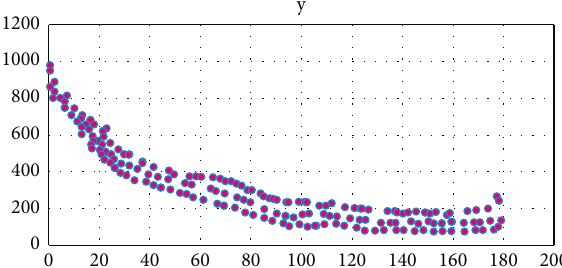
Figure 11: When the crust is taken into account, the scattering spectrum for globes with a radius of 13.4 micrometres is 14.5 micrometres [6].